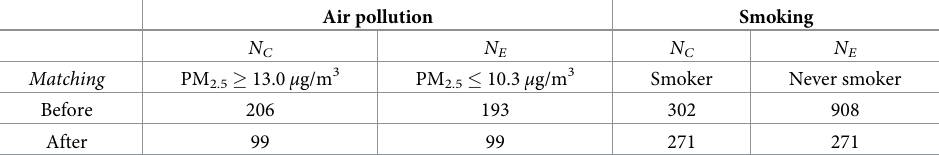
Table 2. Before and after matching number of units. The thresholds for the air pollution experiment are based on 90 th and 10 th percentiles of the PM 2.5 distribution.